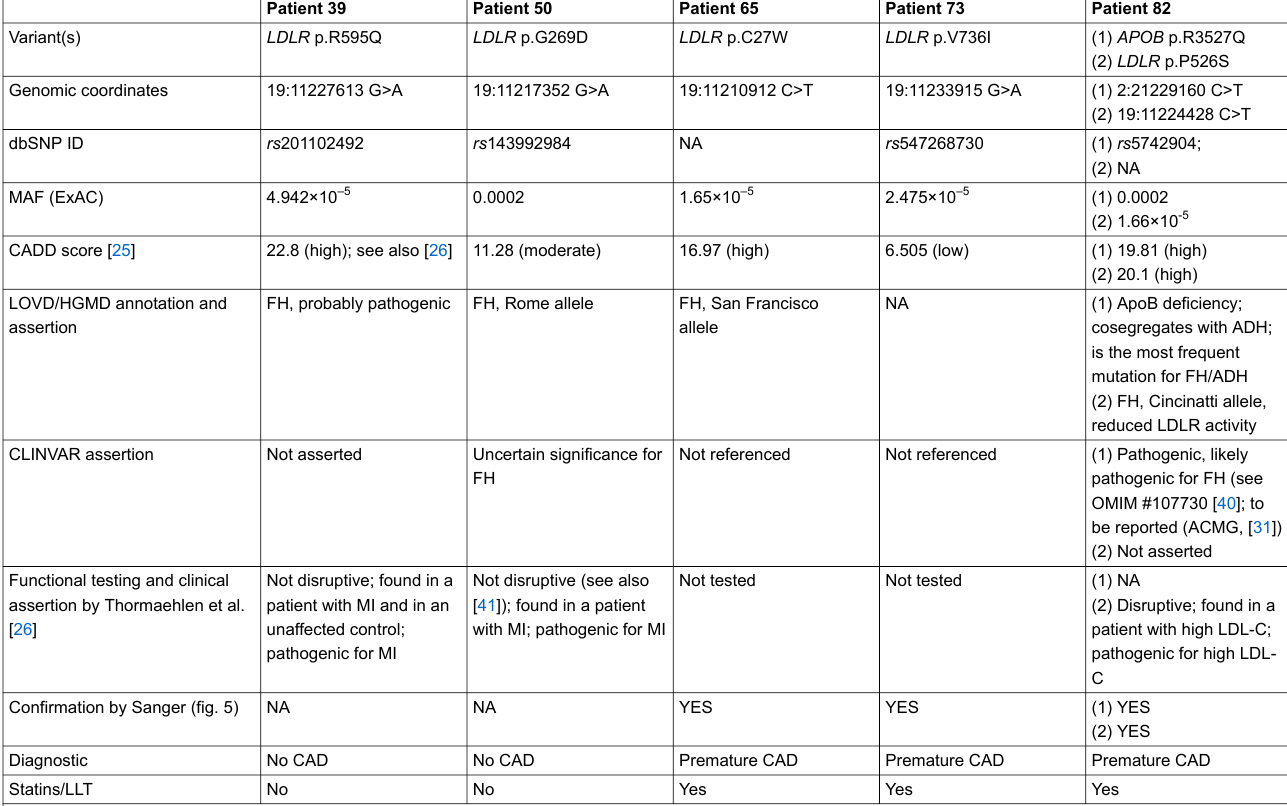
Table 2: Details of the primary rare, missense, coding variants. Data are presented for five variant carriers, two females, three males. All of these patients were aged 18-60 yr at time of top cholesterol testing and presented with plasma triglyceride levels ≤2.2